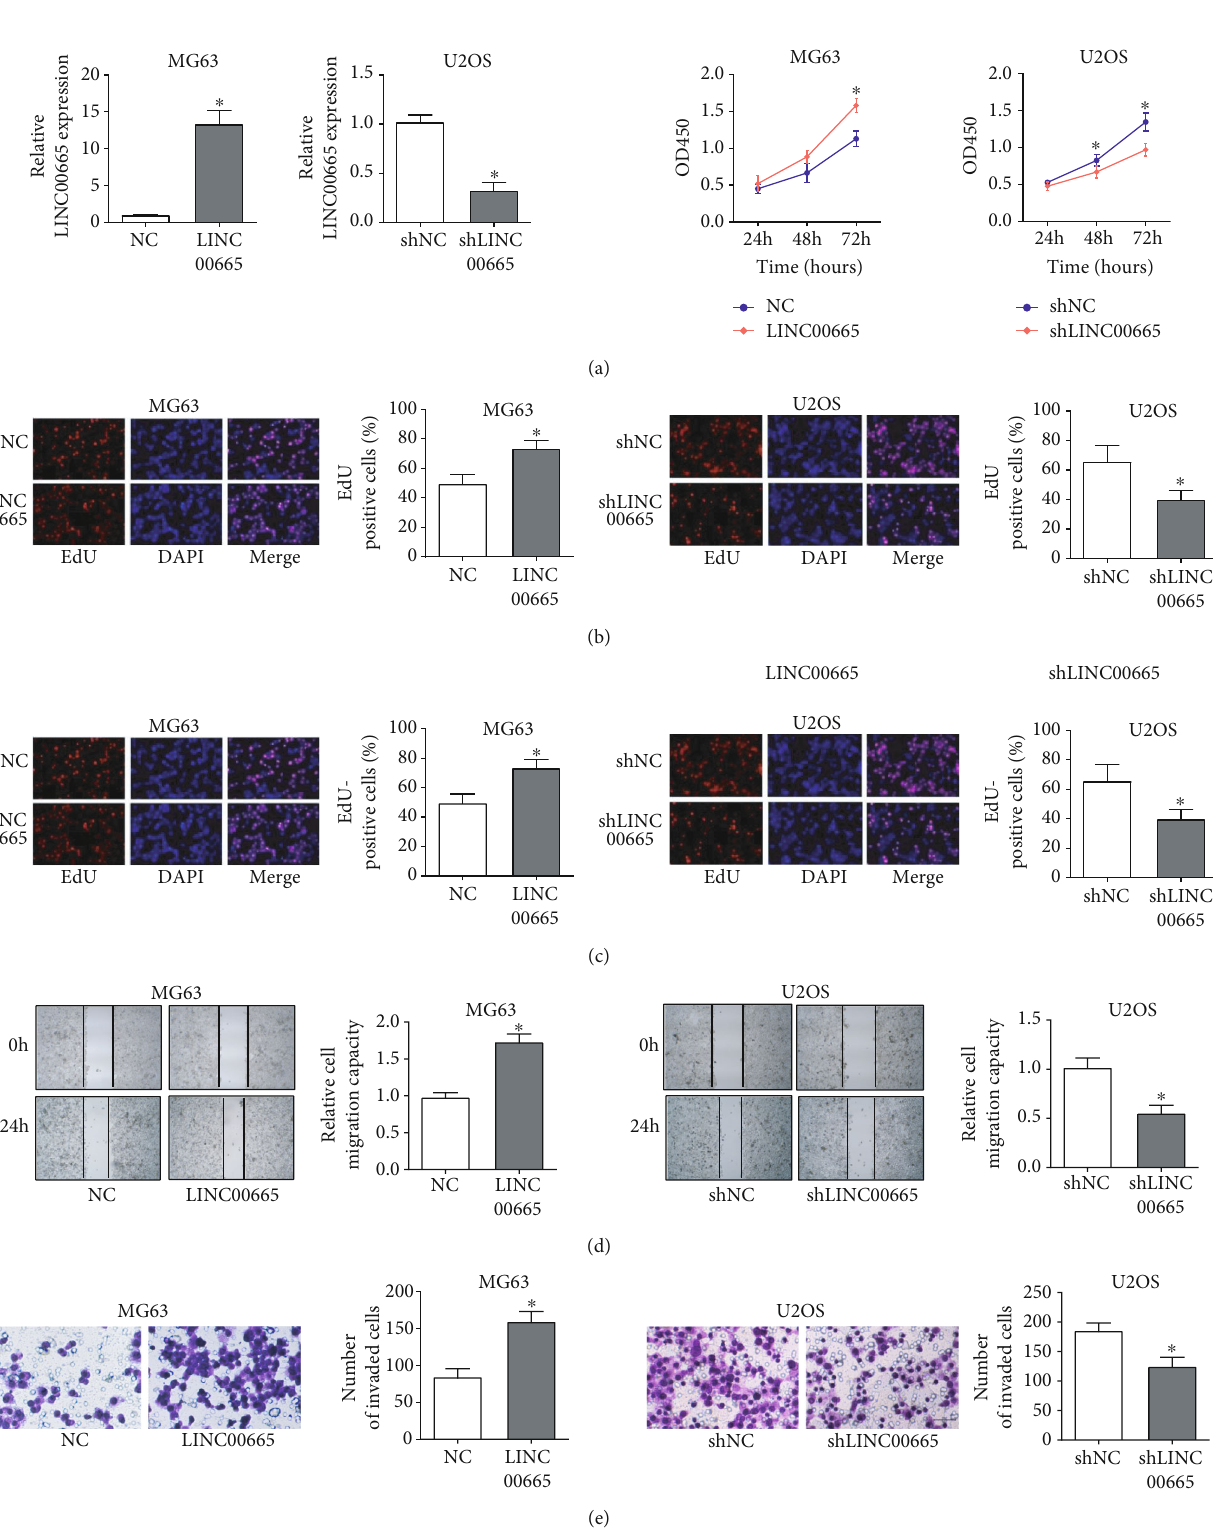
Figure 2: LINC00665 facilitates the malignant progressions of OS cells. (a) Overexpression or knockdown e ffi ciency of LINC00665 in OS cells was determined by RT-qPCR analysis. (b, c) The impact of the LINC00665 overexpression or knockdown on OS cells proliferation was examined by CCK-8 assays (b) and EdU assays (c). (d, e) The e ff ects of LINC00665 overexpression or knockdown on OS cells migration and invasion were assessed by wound-healing assays ((d), magni fi cation, 40 × ) and transwell assay ((e), magni fi cation, 100 × ). ∗ P < 0 : 05